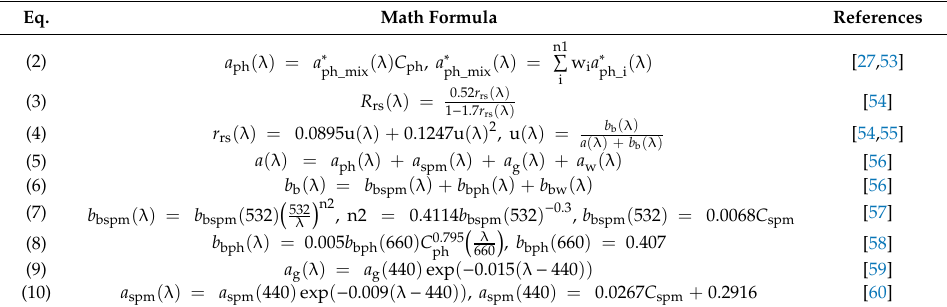
Table 2. R rs simulated formulas based on semi-analytical models in this